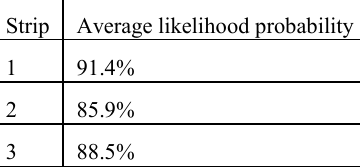
Table 1: Average likelihood